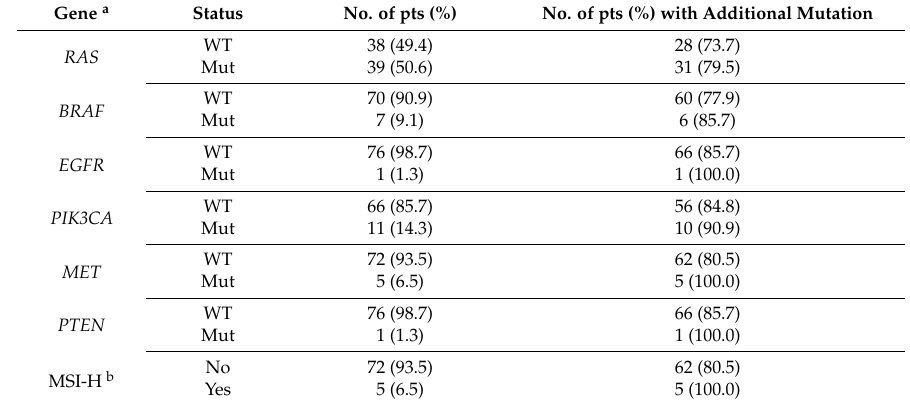
Table 2. List of the genes carrying actionable mutations in the studied metastatic colorectal cancer (mCRC) patients.